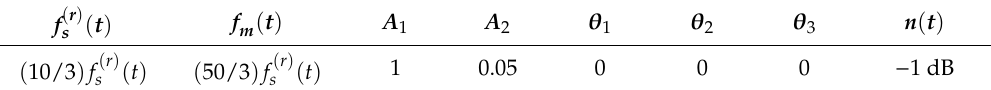
Table 2. Parameters of simulated